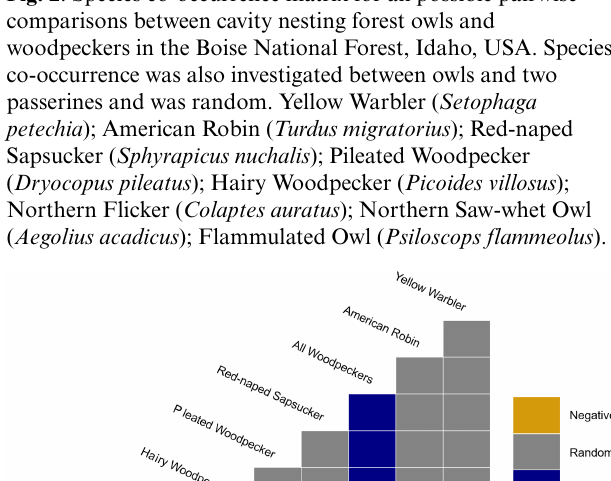
The CCA ordination of landcover variables explained only 14% of the total variation in cavity-nester occurrence, 72% of which was accounted for by the first two principal axes (Fig. 3). The first axis largely represented a gradient in heterogeneity of terrain